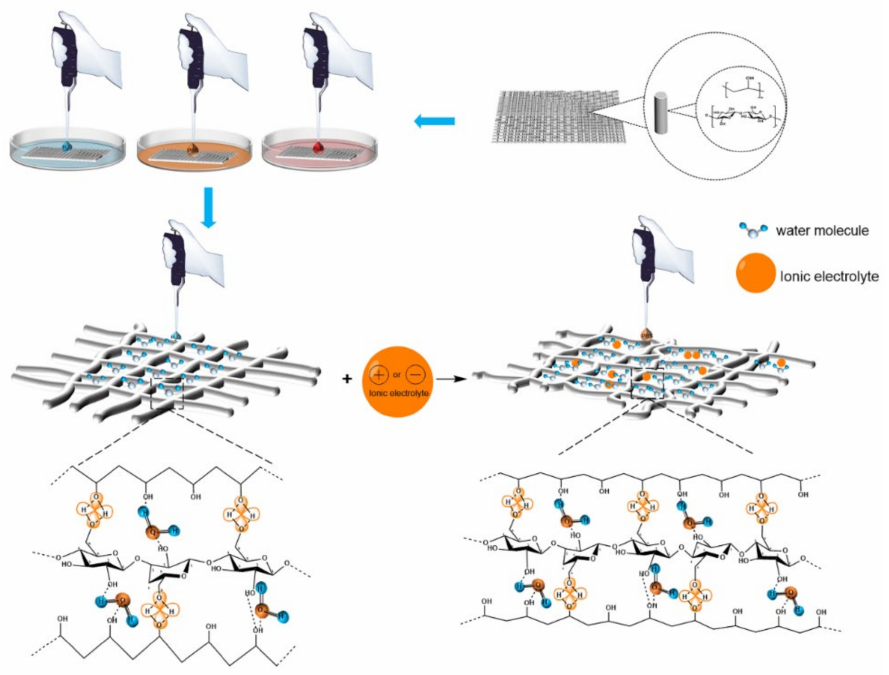
Figure 11. The interaction mechanism between PVA/NC nanofiber membranes with different content of NC and liquids.